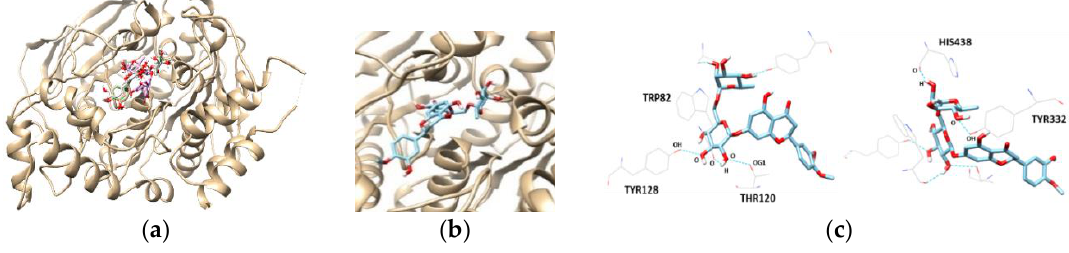
Figure 6. The best docked poses between BChE and hesperetin ( a ).View of the binding site magnified from hesperidin ( b ). Hydrogen interaction diagram of hesperidin ( c ). The blue dotted lines indicate hydrogen bonds between flavanones and BChE.